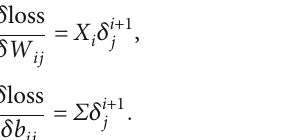
Table 3: CNN parameter